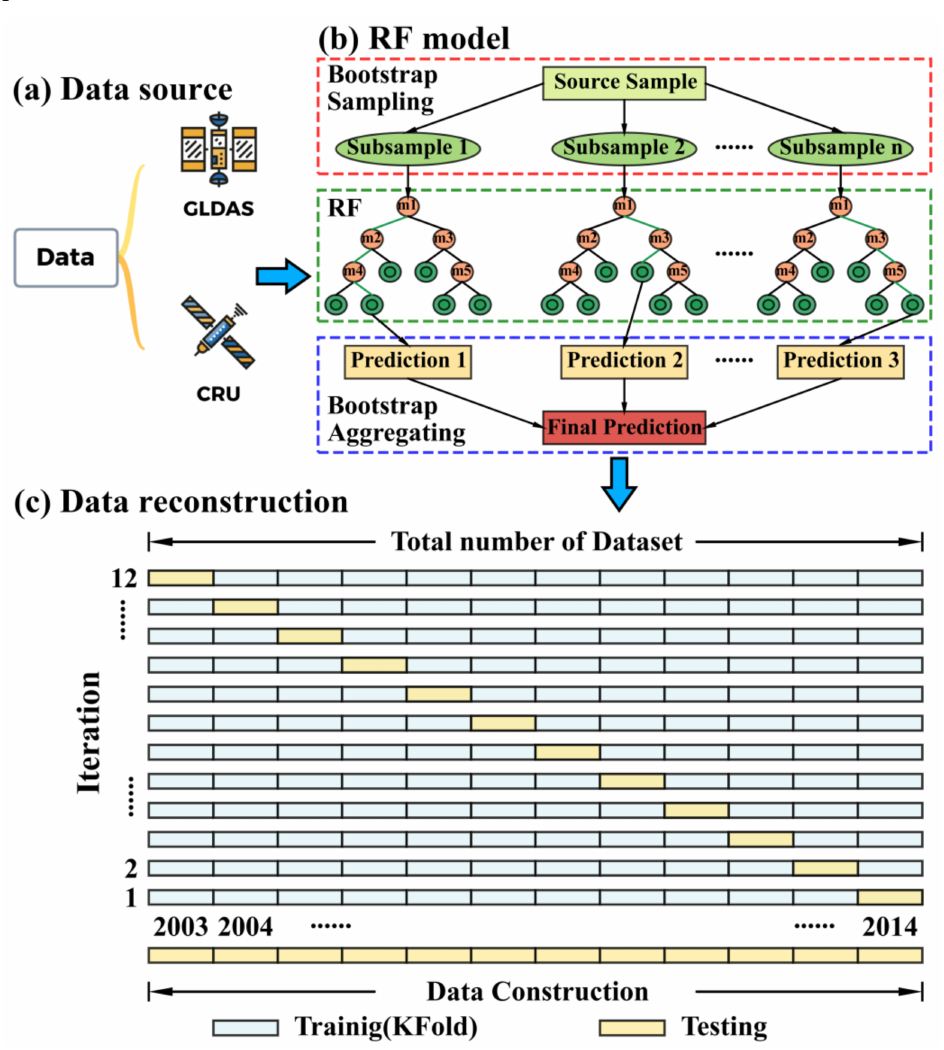
Figure 2. The reconstruction of the TWSA data for the RF model. ( a ) Forcing datasets; ( b ) Schematic of random forest algorithm; ( c ) Reconstruct TWSA using K-fold